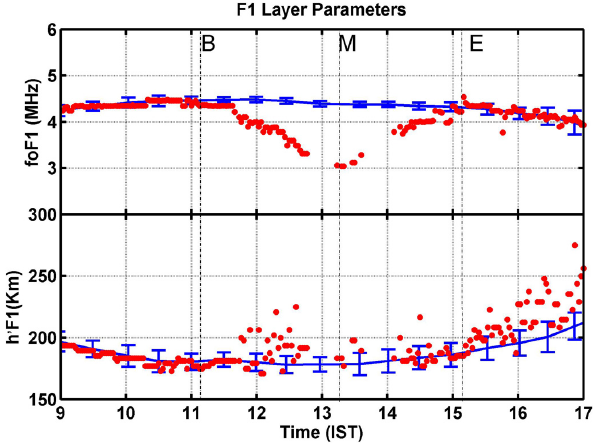
Fig. 4. Top and bottom panels show the temporal variations of the comparison of fo F1 and h 0 F1 from the control days. The blue line with error bar represents the mean values for the control days. Red stars correspond to the observations of eclipse